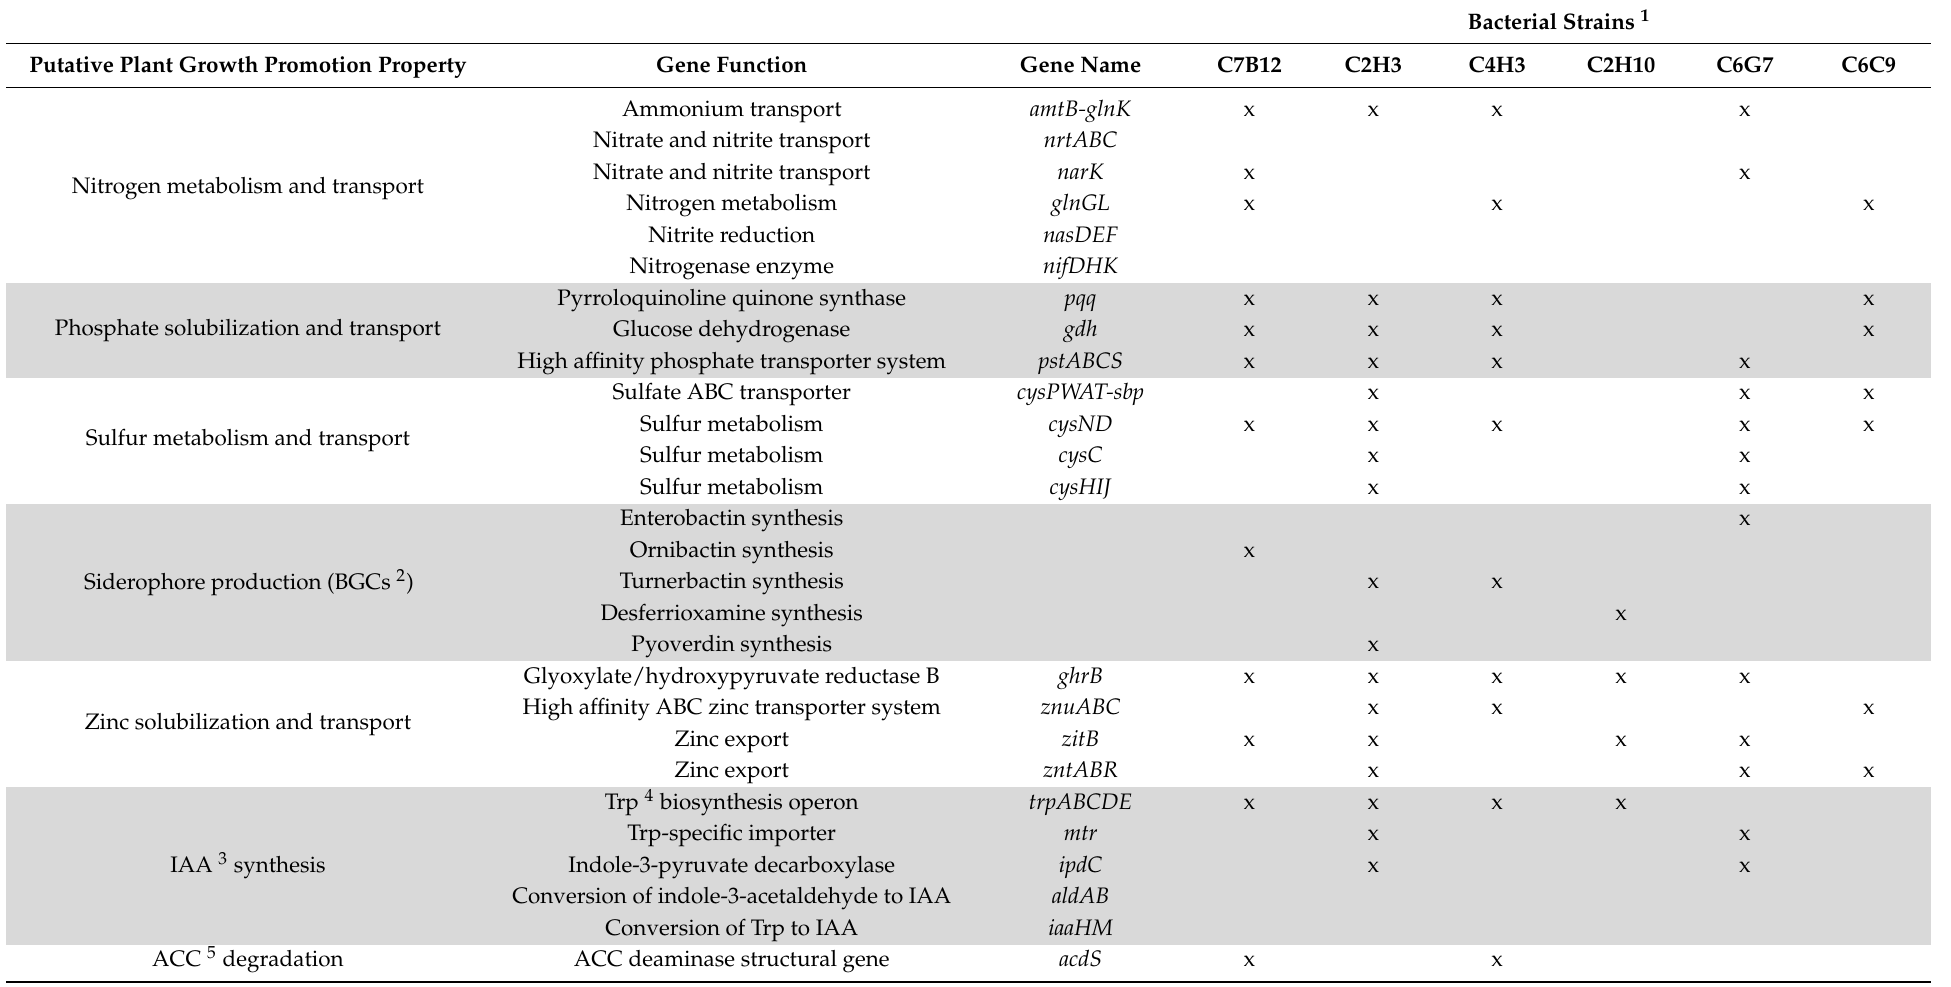
Table 3. Genes related to plant performance (i.e., growth promotion and stress tolerance) identified in the overall top-performing bacterial